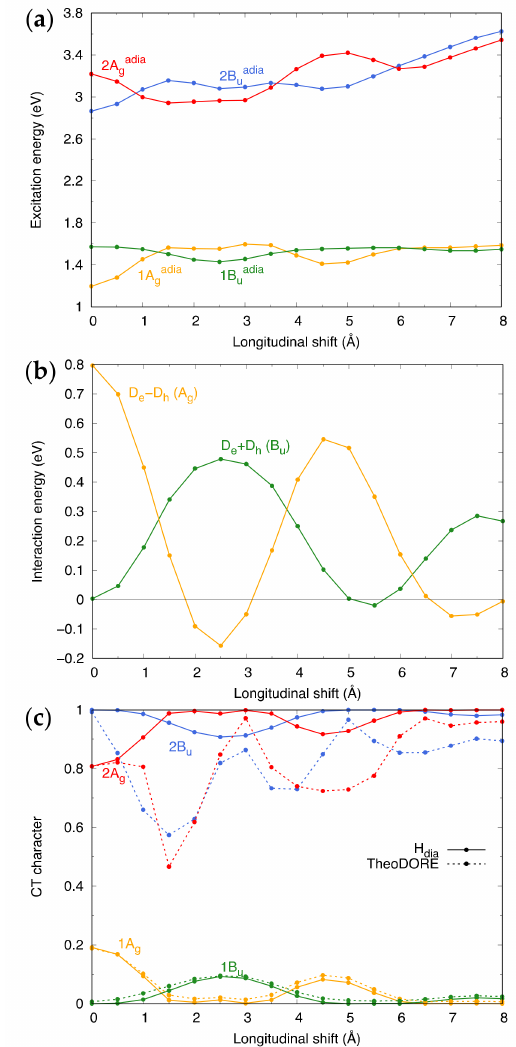
Figure 4. Analysis of triplet exciton states of the PDI dimer (TDA- ω B97X-D/6-31G*). ( a ) Com- puted adiabatic excitation energy profiles. ( b ) Magnitude and modulation along the longitudinal translation coordinate of the D e ± D h terms for the interaction between CR/FE states of the dimer. ( c ) Comparison between the CT character determined with the procedure described in Section 2 and with TheoDORE [66] for the selected triplet exciton states of PDI